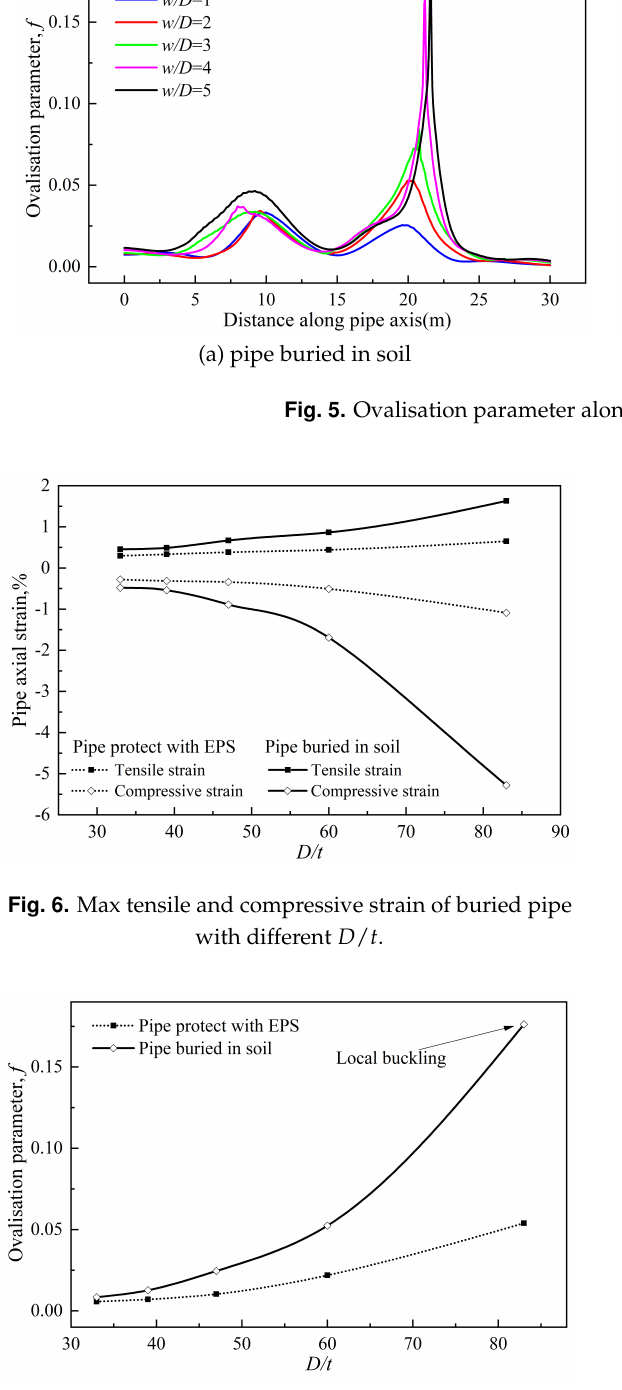
Fig. 8. Max tensile strain of buried pipe with